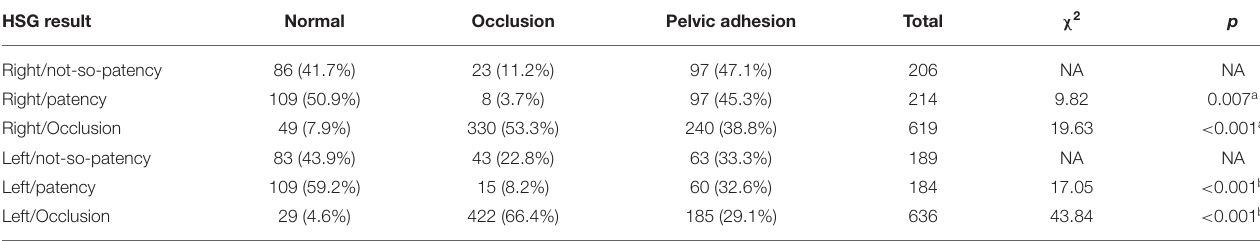
TABLE 1 | Relationship between the diagnosis of each tube by hysterosalpingography (HSG) and by laparoscopy ( n , %). HSG